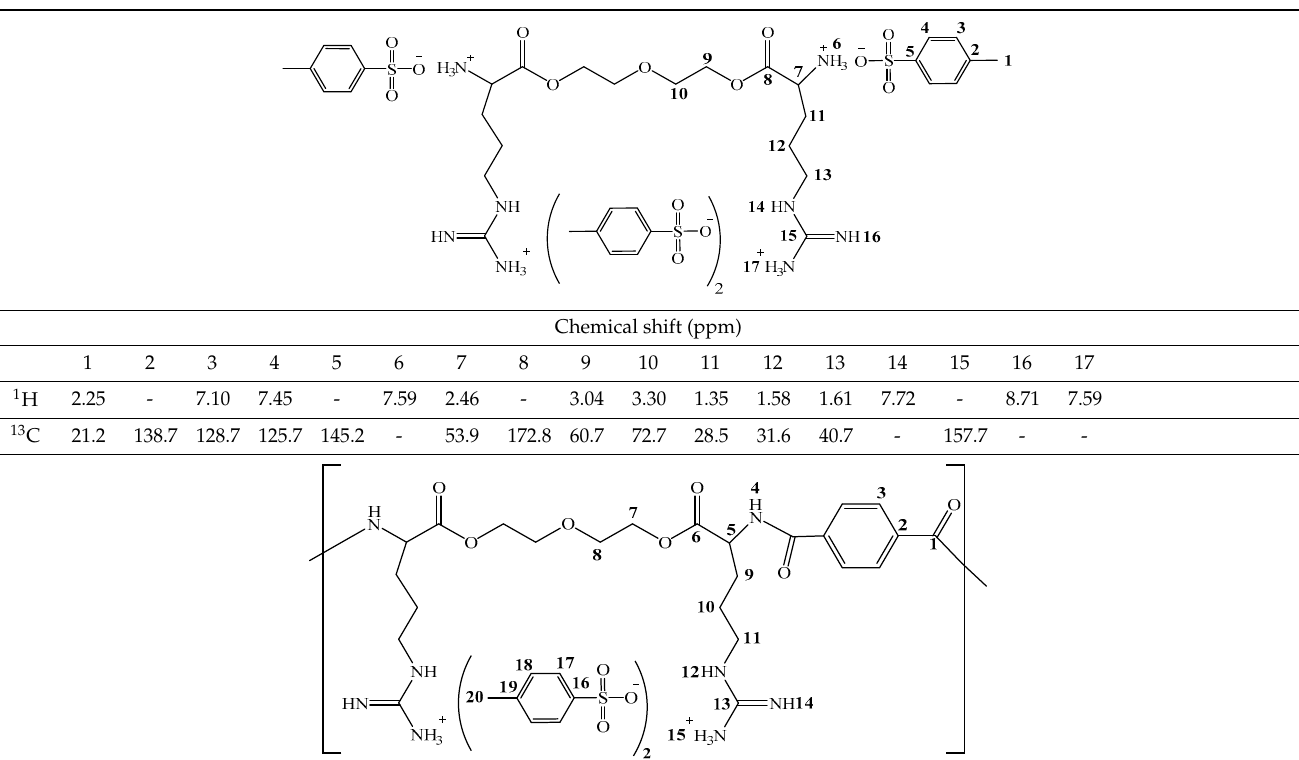
Chemical shift (ppm)